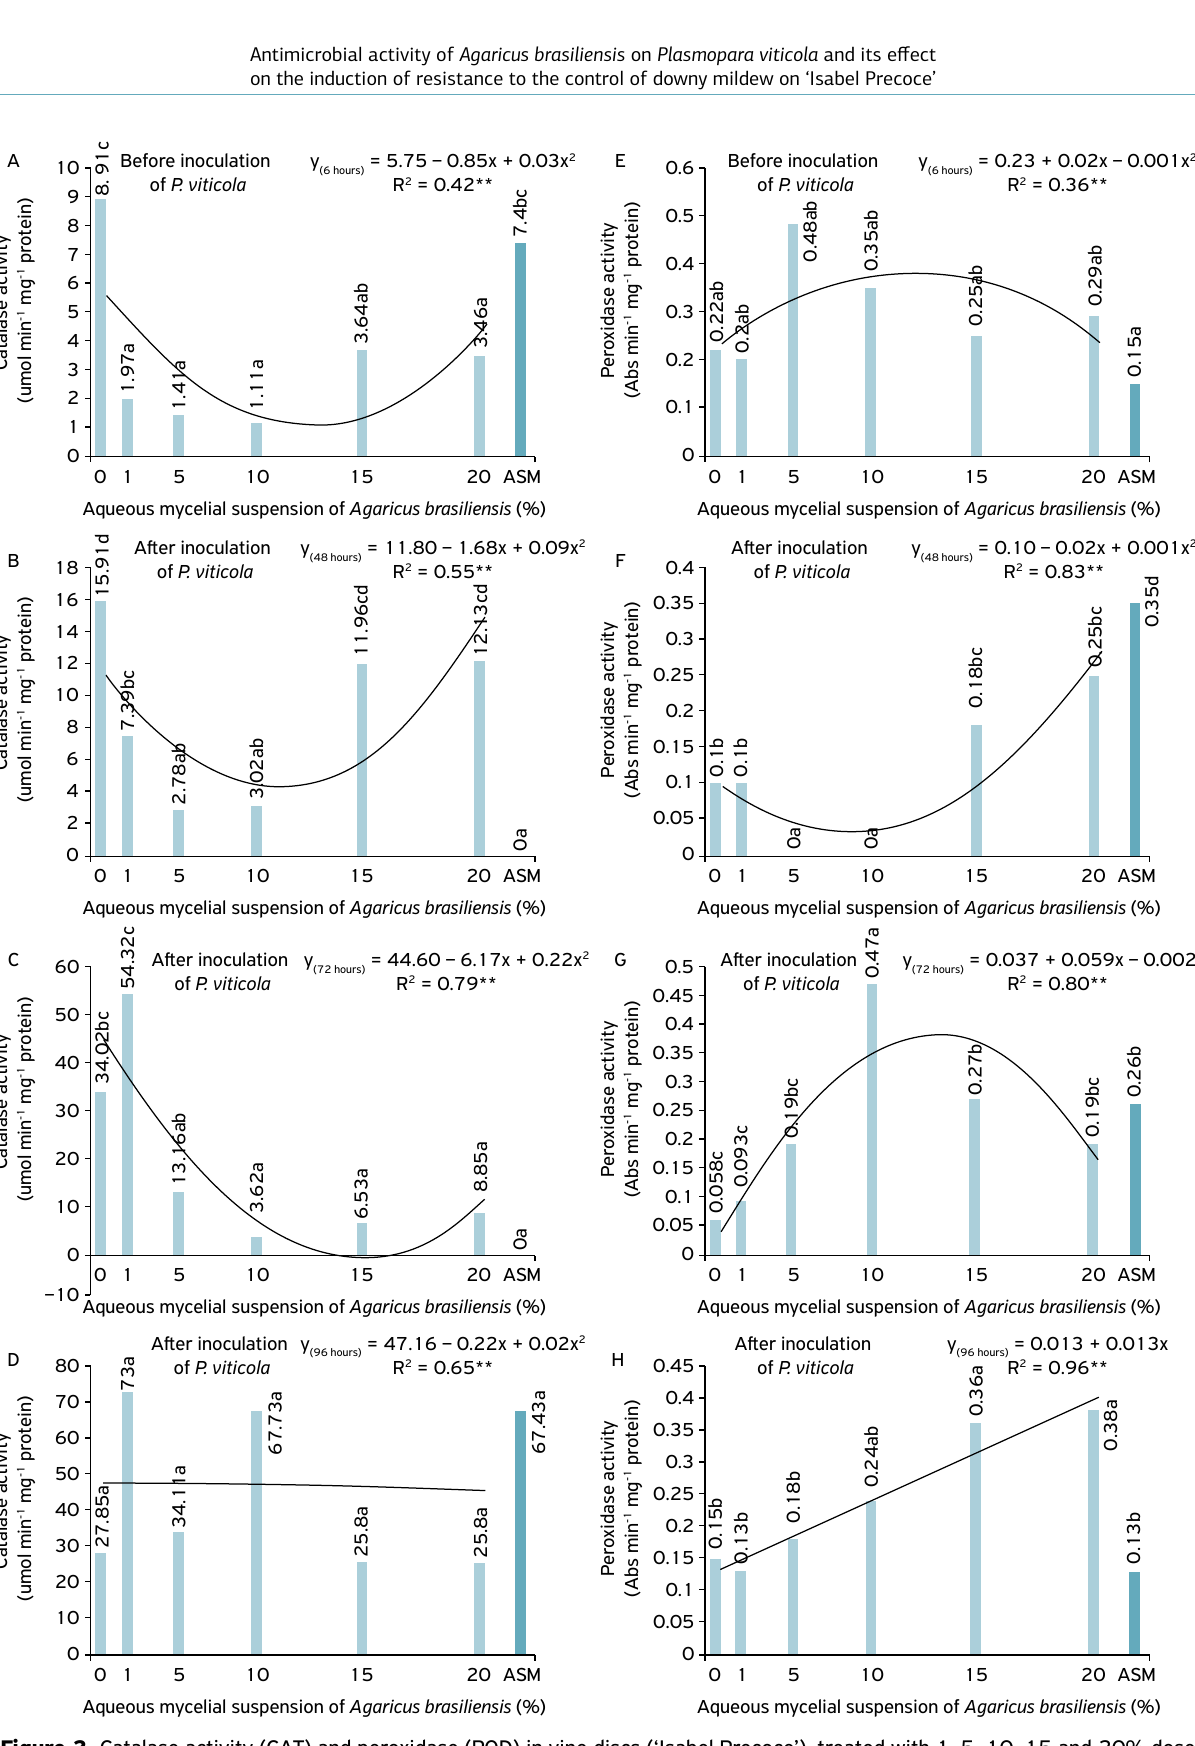
Figure 2. Catalase activity (CAT) and peroxidase (POD) in vine discs (‘Isabel Precoce’), treated with 1, 5, 10, 15 and 20% doses of the Agaricus brasiliensis aqueous mycelial suspension, Acibenzolar‑S‑methyl (0.005%), and absolute control collected 6h (A), 48h (B), 72h (C) and 96h (D) after application of the treatments for CAT, and E, F, G and H for POD activity, in the same periods, after application of the same treatments. Regression analysis performed only for the doses of A. brasiliensis AMS. For ASM treatment, averages followed by the same letter do not differ by the Tukey test at 5% confidence